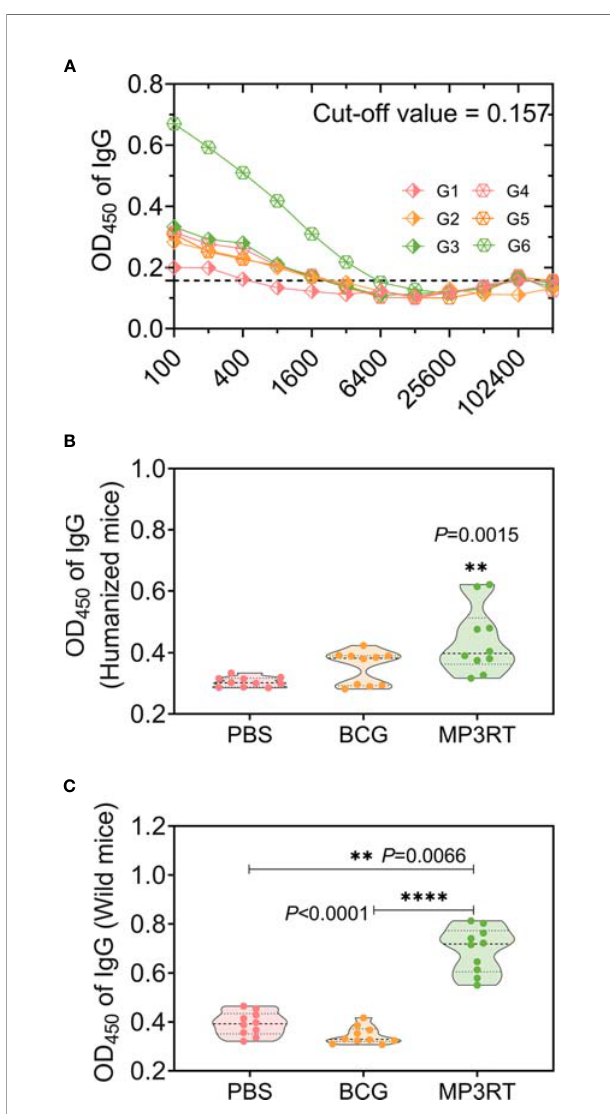
FIGURE 9 | MP3RT-speci fi c IgG antibody. Ninety-one daysafter the fi rst immunization,the mice in each were killed,and their bloodsamples were collected for preparingsera. The MP3RT-speci fi c antibodies were detected with ELISA assay. The optimum dilution of IgG (A) insera of humanizedorwild-type mice immunized with PBS (G1 or G4 group), BCG (G2 orG5 group),and MP3RT (G3 or G6 group) were determined with a cut-off value. The OD 450 ofIgG antibody insera of humanized (B) or wild-type mice (C) was analyzed with a microplatereader.The signi fi cant differences of OD 450 of IgG were analyzed using the one-way analysisofvariance (ANOVA)or Kruskal-Wallistest according to the data normality and homogeneity of variances. Data were shown as mean ± SEM ( n = 10). P <0.05 was considered signi fi cantlydifferent. ** P <0.01; **** P